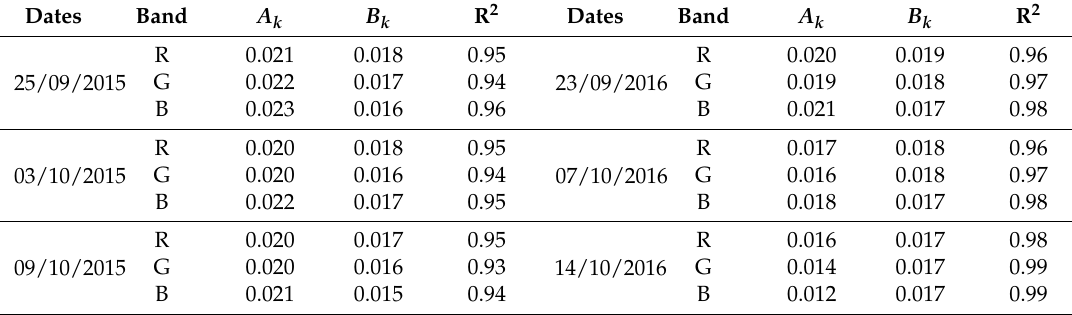
Figure 7. Sample calibration curves of the red, green and blue (RGB) band sensors mounted on the unmanned aerial vehicle (UAV) (data were obtained from a flight performed on 7 October 2016). Table 4. Coefficients of calibration curves of the red, green and blue (RGB) sensors obtained on all flight dates: A k and B k are the coefficients of the exponential relationship described in Equation